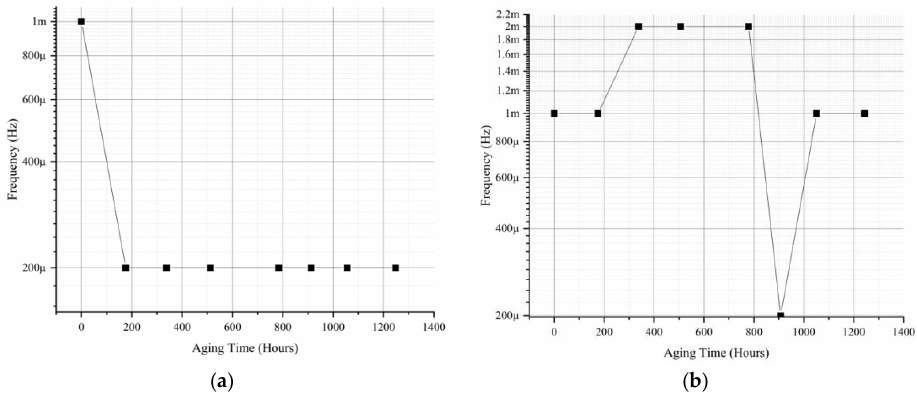
Figure 9. Shifting of the maximum value of the imaginary part of permittivity under ( a ) thermal, and ( b ) thermo-mechanical